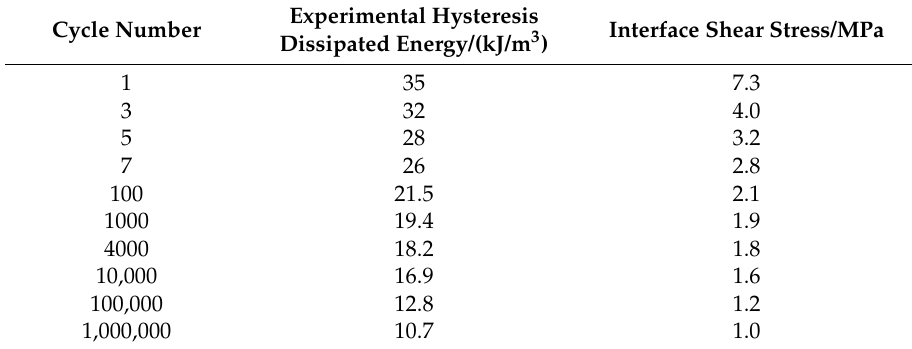
Table 1. The interface shear stress of cross-ply C/SiC composite corresponding to different applied cycles under fatigue peak stress of σ max = 105 MPa at room temperature.